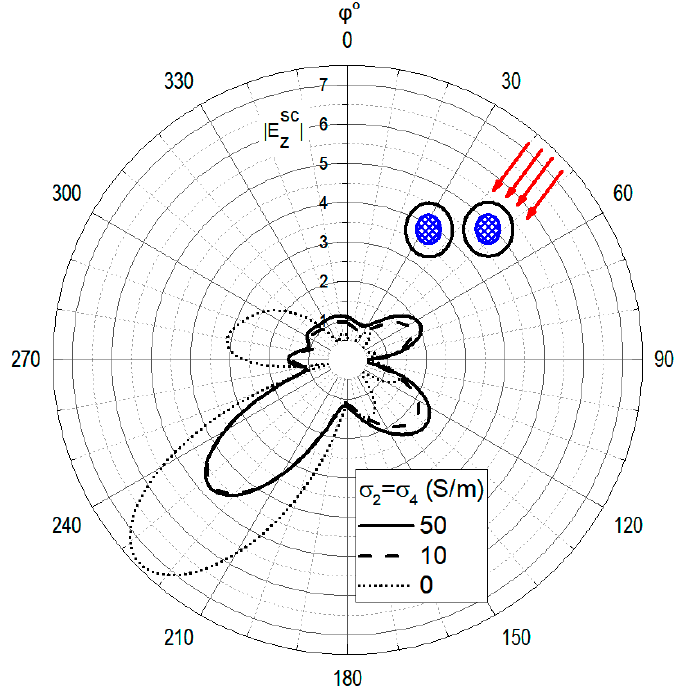
=ϕ Figure 6. The far electric field pattern ( ϕ = ϕ 1 ) for the inset structure, arising from that of Figure 1 Figure 6. The far electric field pattern ( 1 φ ) for the inset structure, arising from that of Figure 1 when L = 3, D 23 = λ 0 , ε 1 = ε 0 , ε 2 = ε 4 = 2.32 ε 0 , α 2 = α 4 = 0.4 λ 0 , ε 3 = ε 5 = 4.34 ε 0 , α 3 = α 5 = 0.2 λ 0 , when L = 3, = µ = 1,2,3,4,5), σ = σ = σ = 0 and σ = σ = 0, 10, 50 S/m, while E µ 3 5 2 1 4 i 0 ( i θ (cid:48) = 70 ◦ and ϕ (cid:48) = 45 ◦ .